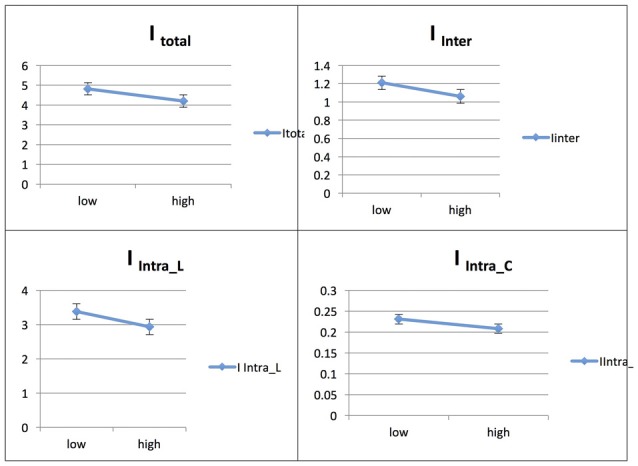
Probability value of the network integration differences across phases for L2 (French) in the Persian-speaking group (L1 = Spanish). I = integration, ITotal = total integration value, IIntra_Language = Intra-integration of language areas, IIntra_Control = Intra-integration of cognitive control areas and IInter = integration between the two networks (language processing and cognitive control). A probability greater than 0.9 is considered significant.